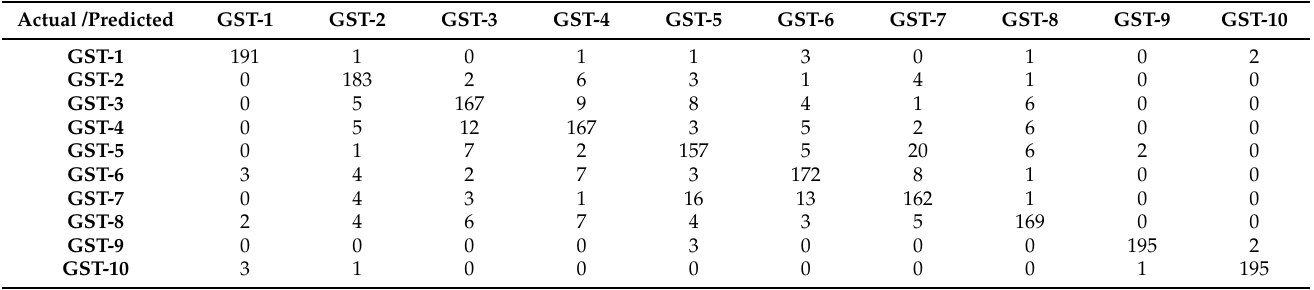
Table 7. Confusion matrix for J48 classifier with the cross-validation factor of 10%.